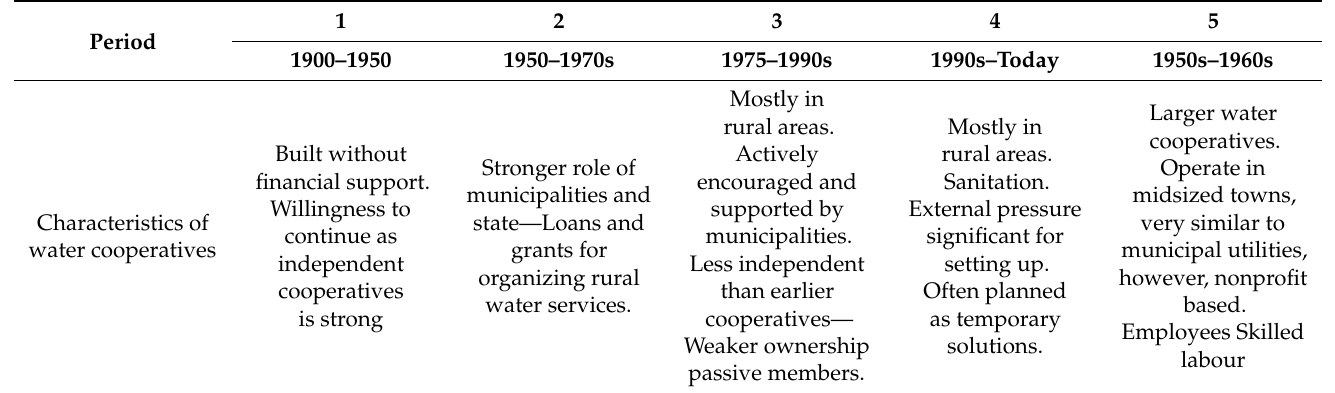
Table 1. Development phases of Finnish Water Cooperatives